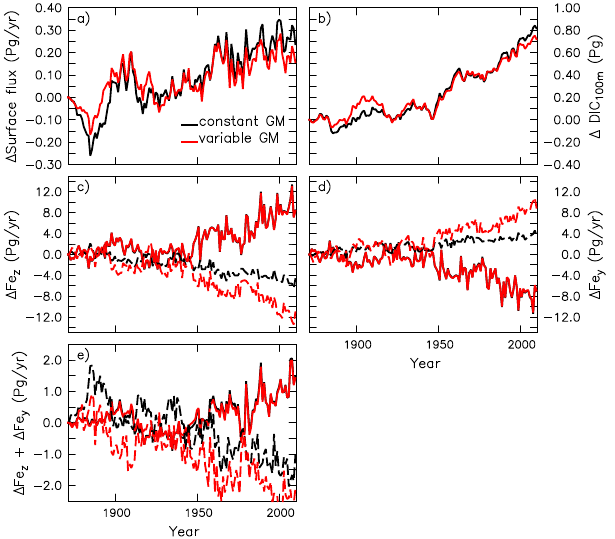
Figure 6. Wind induced effect on (a) surface carbon flux south of 45 ◦ S, (b) DIC inventory integrated south 45 ◦ S and over the up- per 100m, (c) vertical flux of DIC by Eulerian mean advection (solid lines) and by eddy-induced advection (dashed lines) inte- grated south 45 ◦ S, (d) the horizontal components of the DIC ad- vective flux at 45 ◦ S and integrated over 0 to 100m and (e) the total advective flux of DIC given by the sum of (c) and (d) . The wind- induced effect is given by the transient minus fixed experiments, and results are shown for the constant GM (black) and variable GM (red) coefficients.